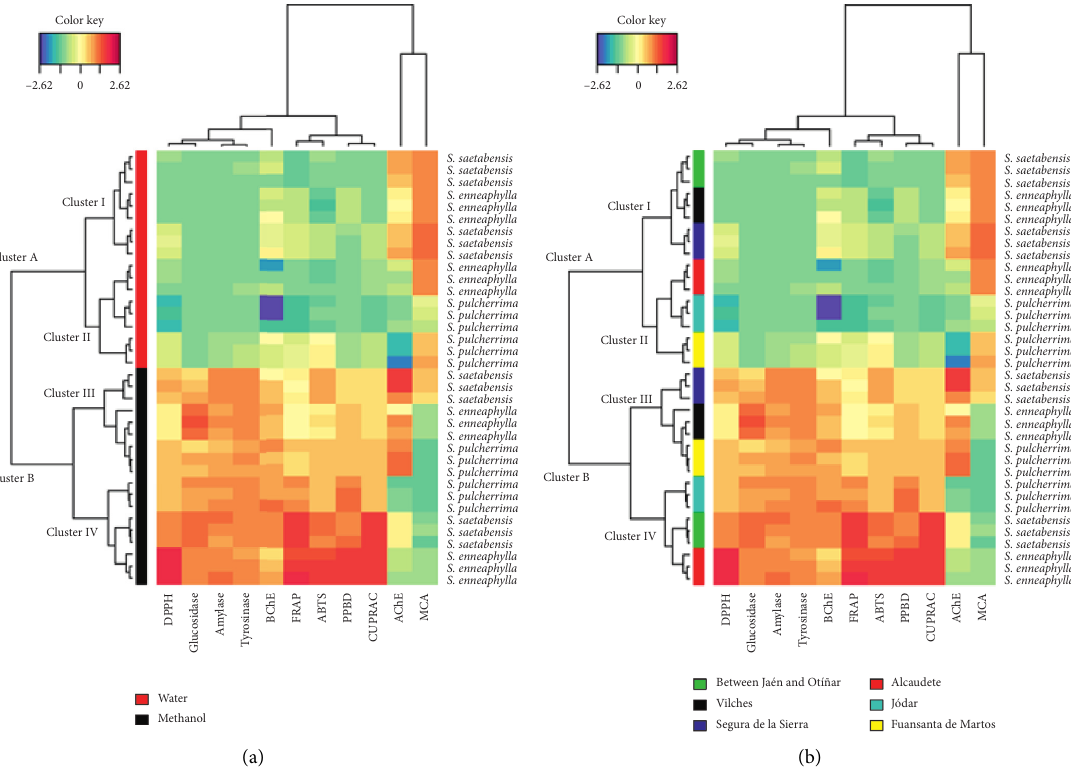
Figure 4: Heatmap and HCA analyses on biological activities of Sarcocapnos species built up from PCA result. (a) Clustering in relation to extractive solvent. (b) Clustering in relation to geographical origin. Red color: strong activity. Blue color: low